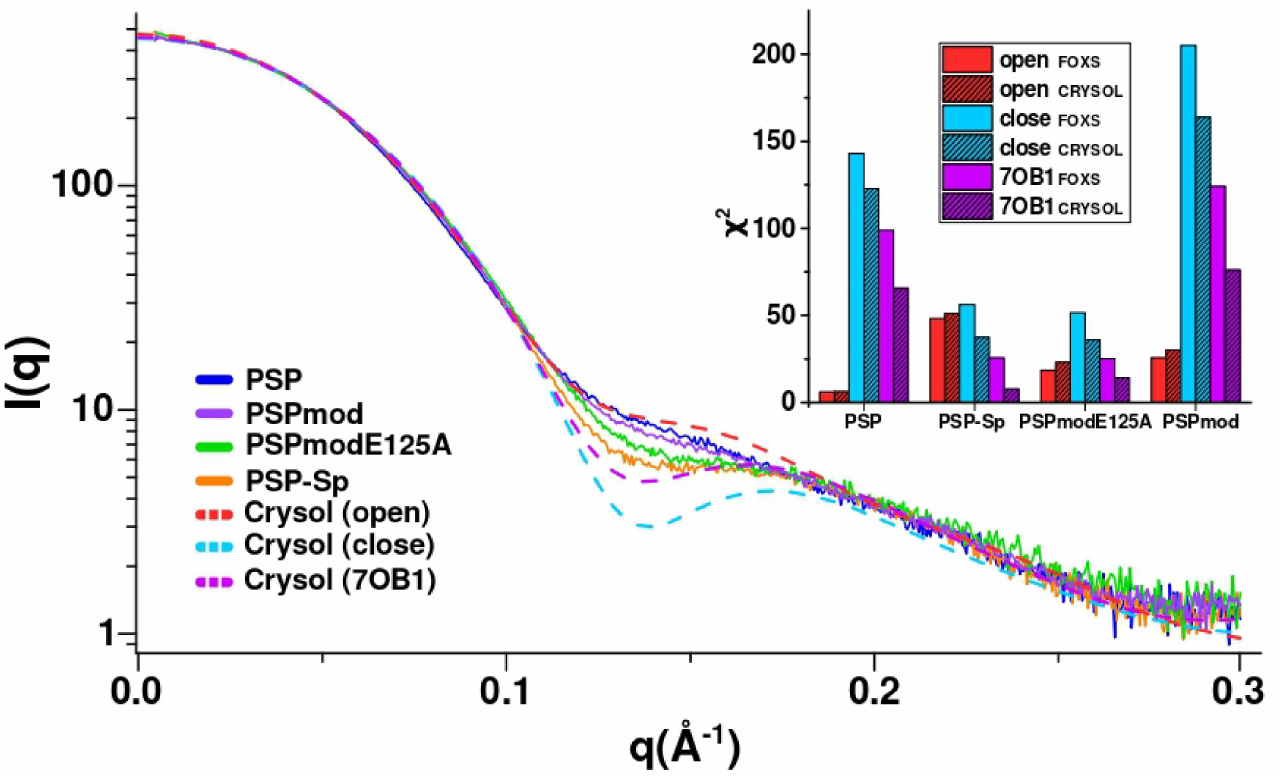
Figure 5. Experimental SAXS profiles (solid) and theoretical (dashed) calculated using CRYSOL for homologous PSP models in open and closed conformations and crystal structure (PDB ID: 7OB1). The inset shows the histogram of the chi-square distribution for FOXS/CRYSOL